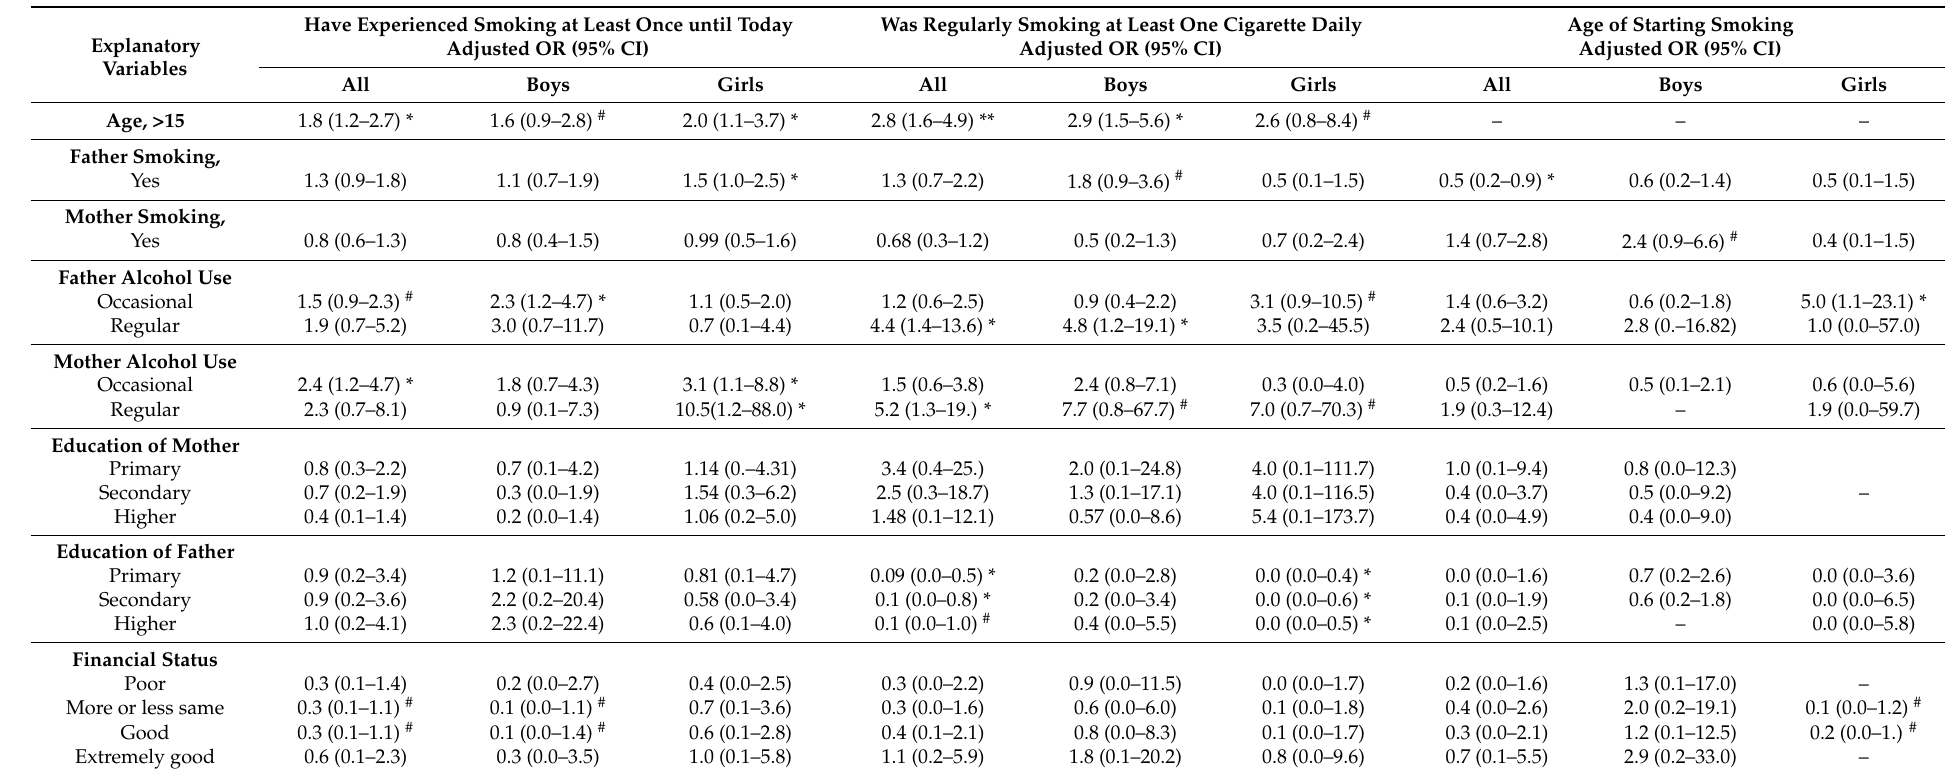
Table 2. Adjusted odds ratio for smoking behaviour